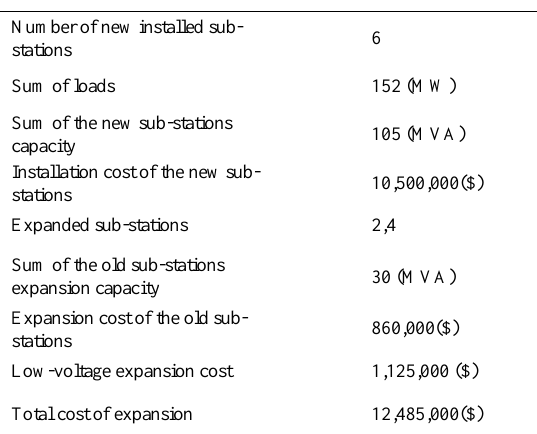
Table 1. Detailed results of applying GA to solve SEP problem on a typical network.